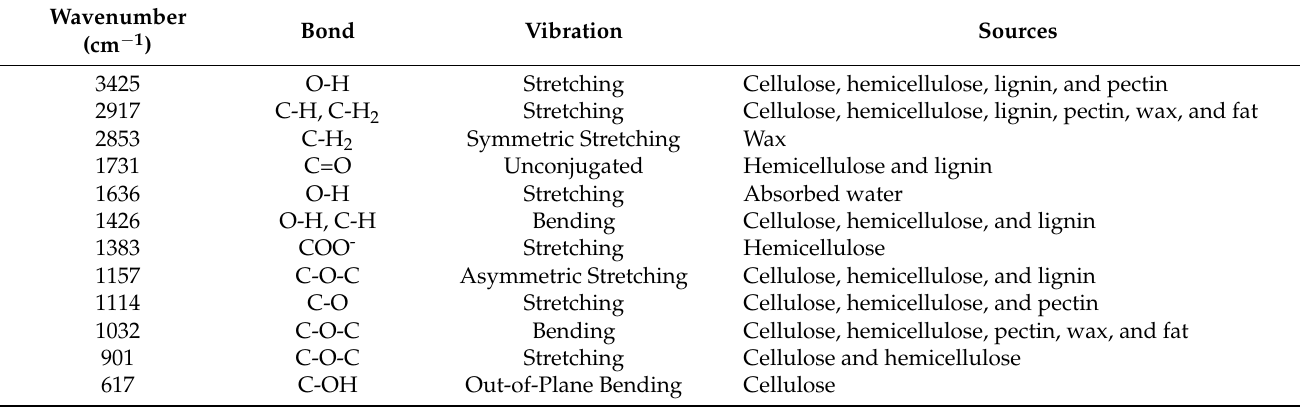
Table 6. Sources of FTIR peaks and their assignments [1,84,86,87].